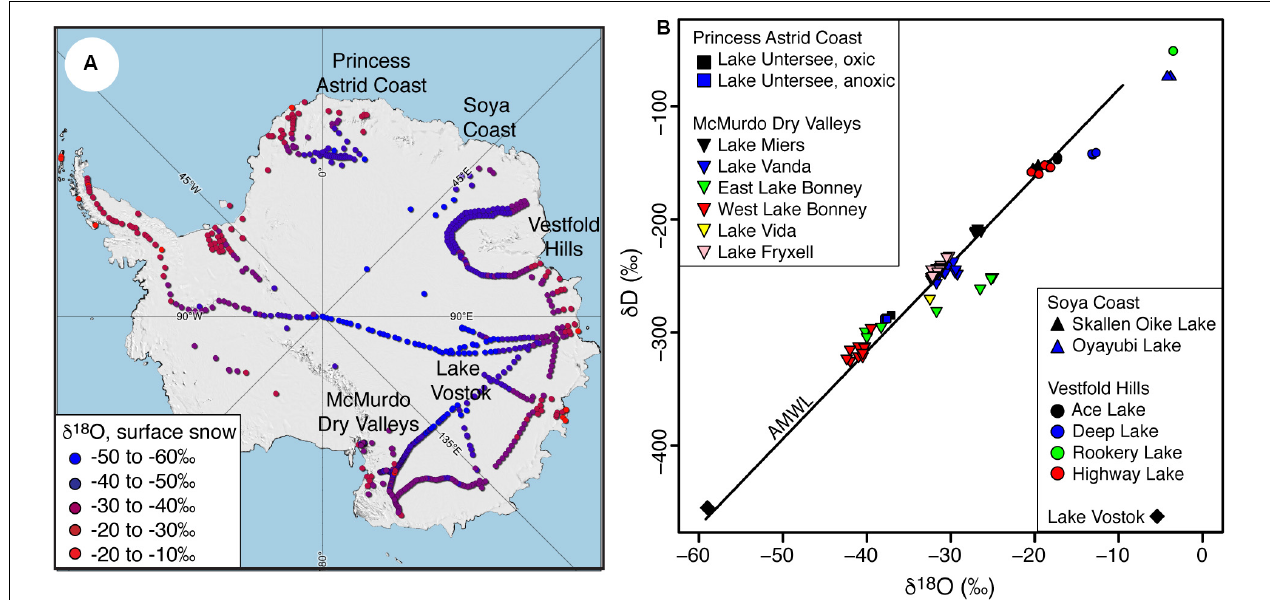
FIGURE 1 | (A) Distribution of surface snow δ 18 O values across Antarctica (data from Touzeau et al., 2016). (B) Stable water isotope ( δ D- δ 18 O) ratios of perennially ice-covered lakes in the Antarctic: Princess Astrid Coast (Lake Untersee), Southern Victoria land region (Lake Miers, Lake Vanda, Lake Bonney, Lake Fryxell,